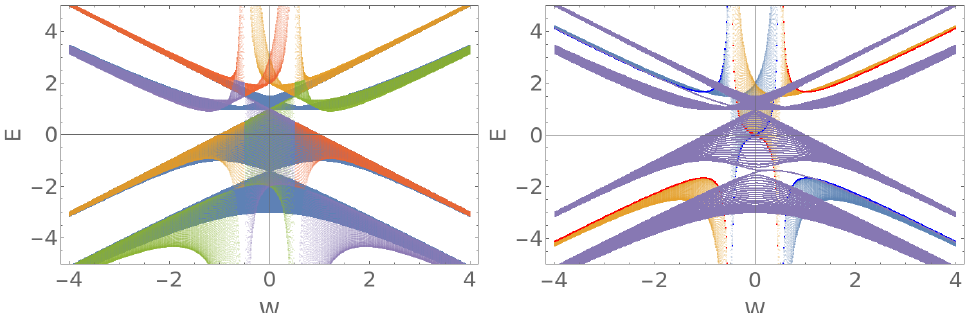
Figure 6: Comparison between the exact spectrum and the spectrum obtained from the projected Hamiltonian. Left panel: the exact spectrum for PBC (blue) and for the lower and upper projected two bands (red, orange, green, purple) as function of W . Right panel: the spectrum for OBC (purple) and the dispersing centers (cid:34) ( k ) (orange) with k = π highlighted (bright blue and red respectively). Here and (cid:34) (cid:48) 0 = 1.0, t = 0.5, and N = t 1 2